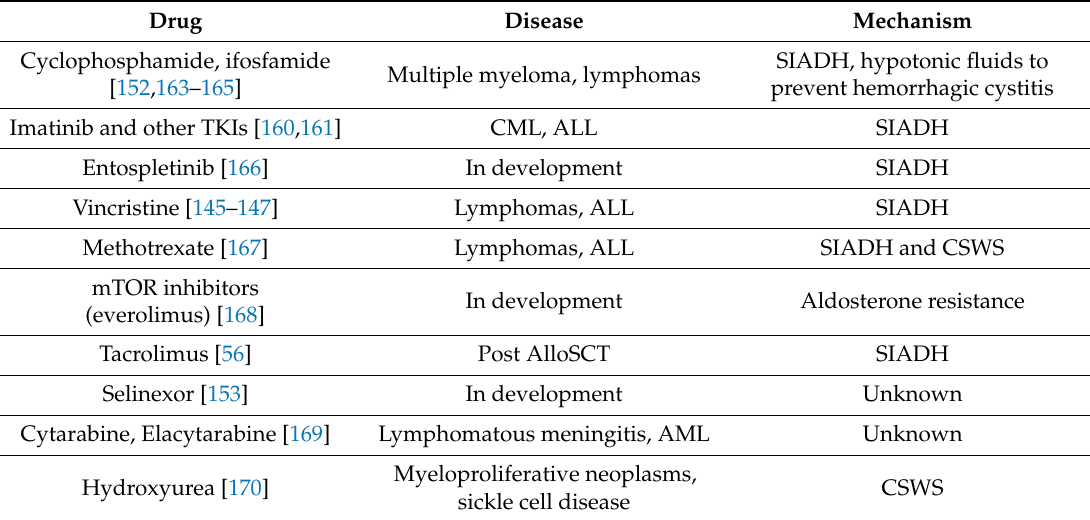
Table 2. Drugs used in clinical hematology and associated underlying mechanisms for hyponatremia. Drug Disease